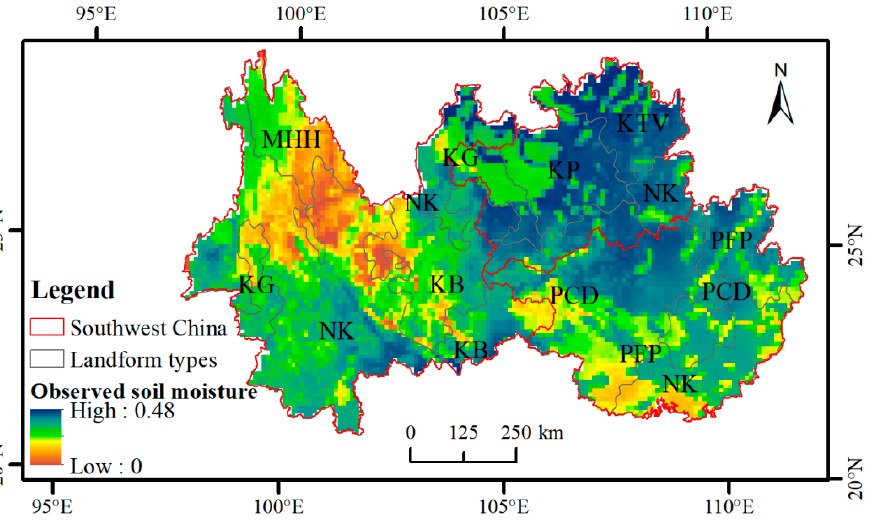
Figure 6. Observed soil moisture in the karst areas of Southwest China from 2000 to 2015 (PFP: peak forest plain; KG: karst gorge; NK: non-karst region; KB: karst basin; MHB: middle-high hill; PCD: peak cluster depression; KTV: karst trough valley; KP: karst plateau).